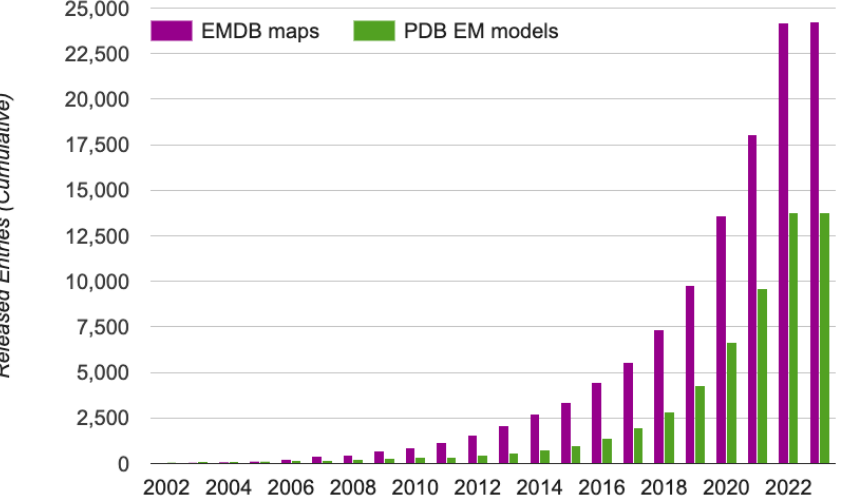
Figure 1. The growth of cryo-EM density maps and cryo-EM-derived protein structures. The statistics were obtained from EMDataResource [34], a unified data resource for 3-Dimension electron microscopy (3DEM) on 20 November